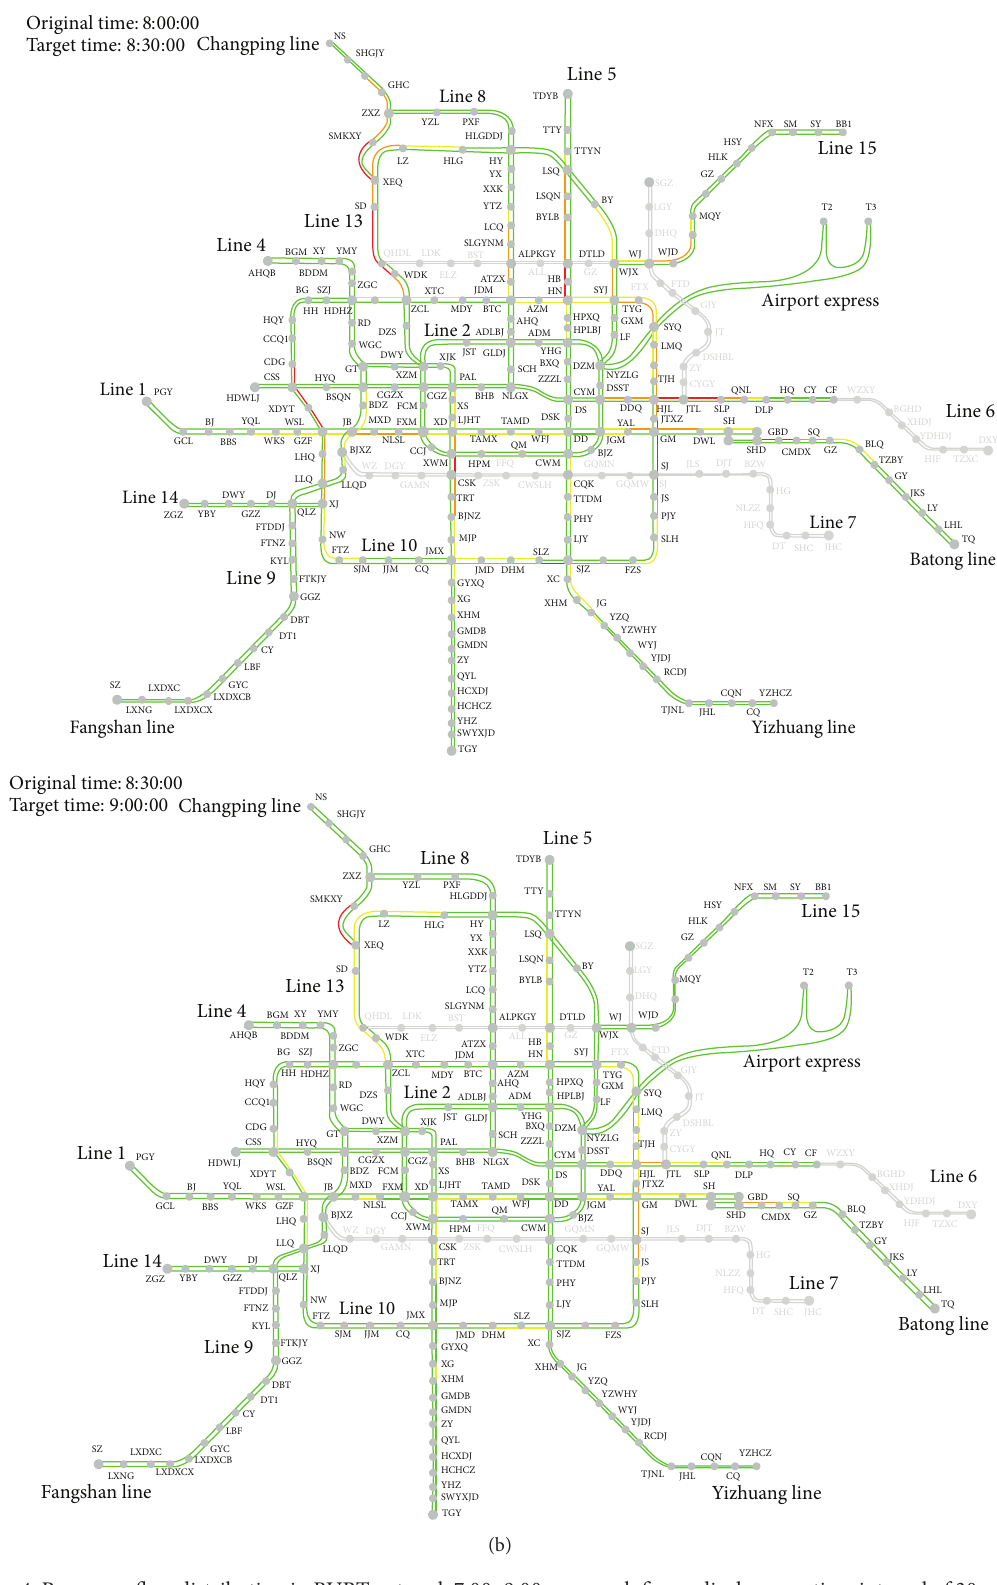
Figure 4: Passenger flow distribution in BURT network 7:00–9:00 a.m., each figure displays one time interval of 30